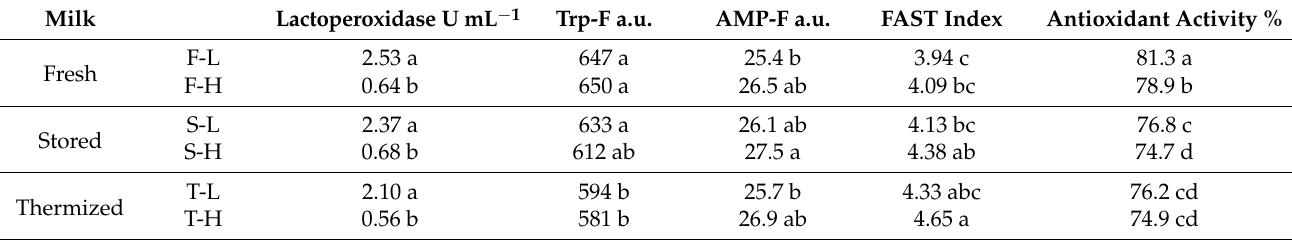
Data are expressed as mean of three repetitions. For each parameter, means followed by a different letter in the column are significantly different ( p < 0.05). Trp-F = tryptophan fluorescence, AMP-F = Maillard’s advanced products fluorescence; FAST = Fluorescence of advanced Maillard products and soluble